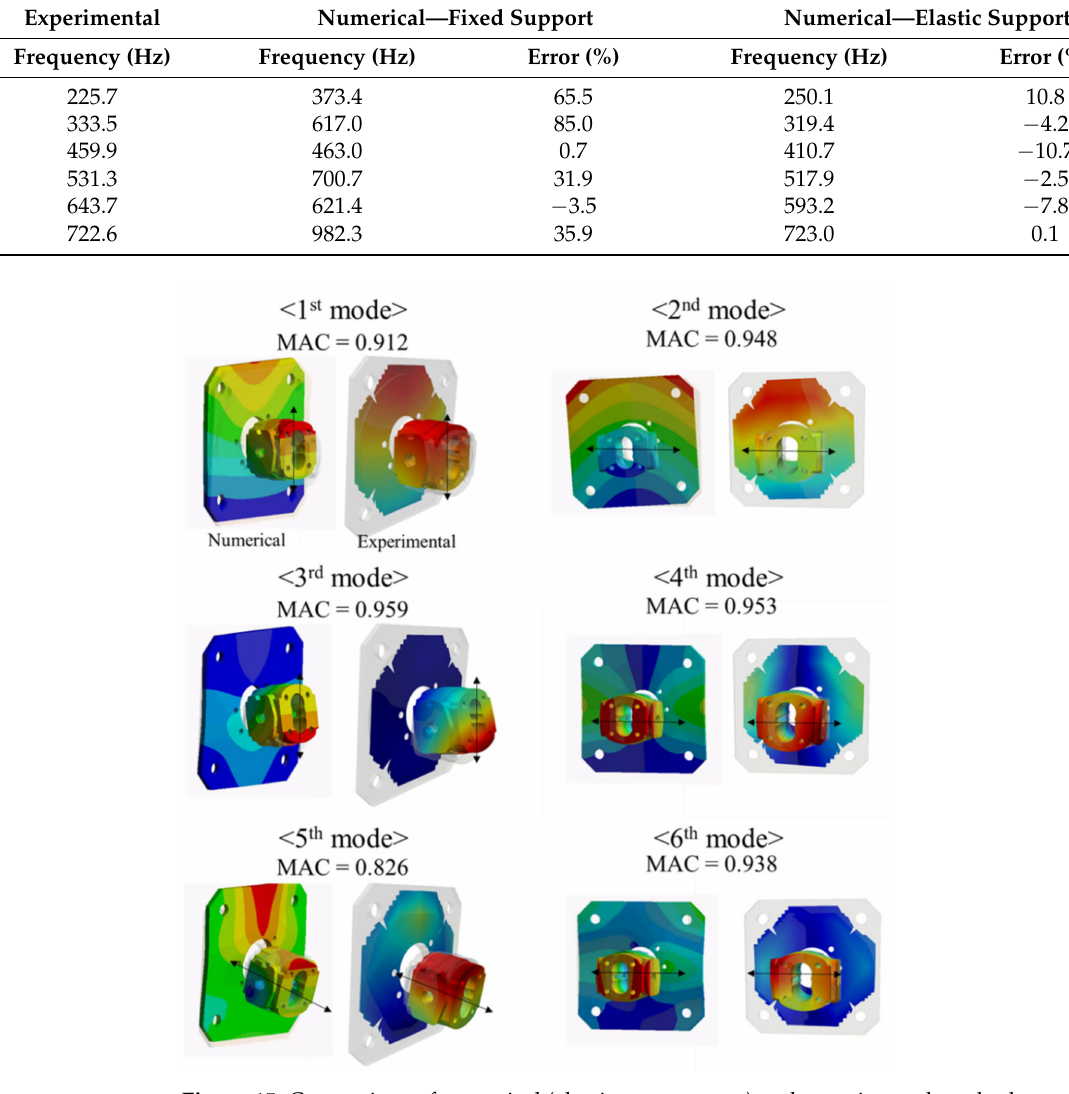
Figure 15. Comparison of numerical (elastic support case) and experimental mode shapes when the pump is